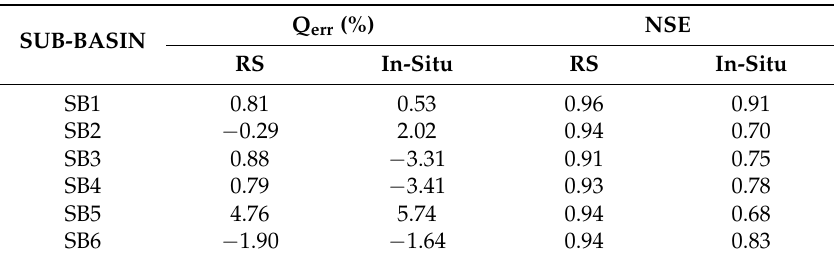
Figure 6. The LMRB model calibration. Monthly mean observed and simulated discharge in m 3 /s at six sub-basin watersheds in calibration of the LMRB model. The calibration time period is from 2005 to 2006. The red circles are simulated discharge with satellite-based, remote-sensing precipitation data input, while the blue rectangles are simulated discharge with in-situ meteorological data input. Here SB stands for sub-basin. Table 3. The LMRB model calibration metric results. The percent error (Q err ) between the monthly mean simulated and observed discharge and the Nash–Sutcliffe Efficiency (NSE) performance metrics are depicted for each sub-basin corresponding to satellite-based remote sensing (RS) and in-situ data input, respectively.